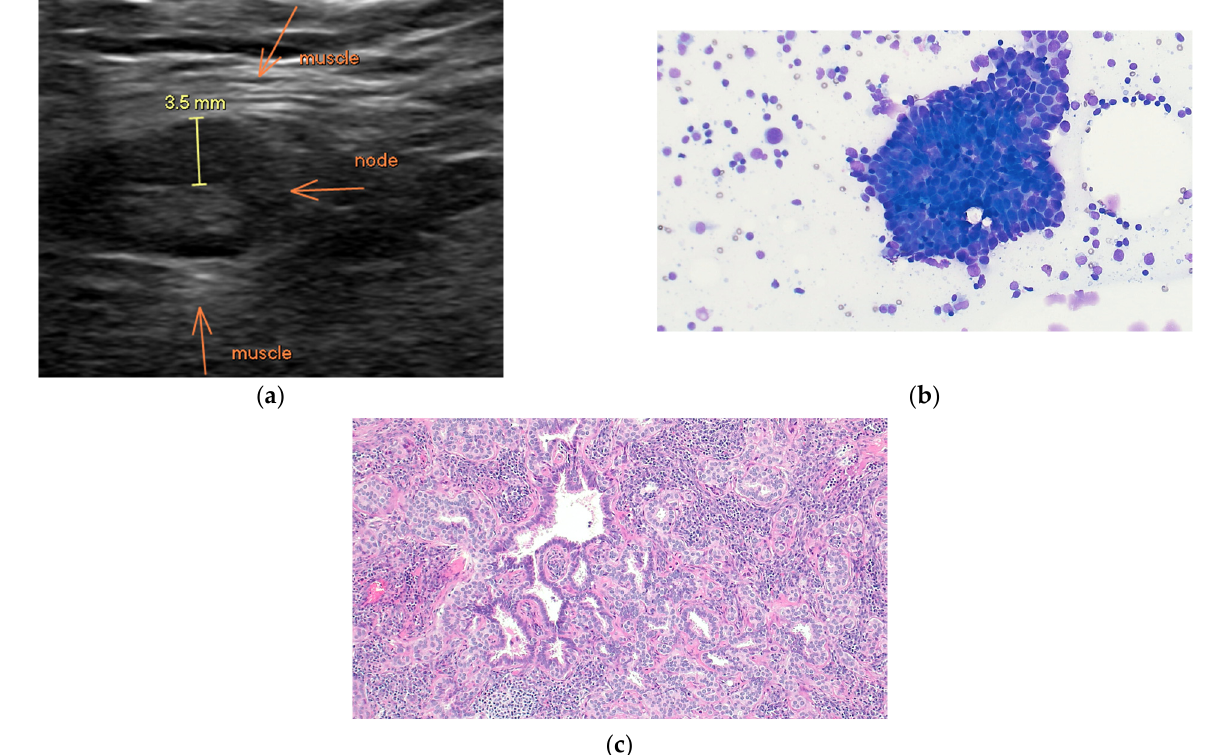
Figure 10. ( a ) Ultrasound depicts a subscapular level one malignant node confirmed with FNAB ( b ), the smears demonstrating tubular structures of low nuclear grade atypical cells. DQ ×200. The breast demonstrated a 33 mm grade 1 invasive ductal carcinoma; however, no metastases were found in 25 axillary nodes. Repeat FNAB confirmed malignant cells in the subscapular node which was then removed following targeted hook-wire localization and a 3.5 mm metastasis identified ( c ). H&E ×100.